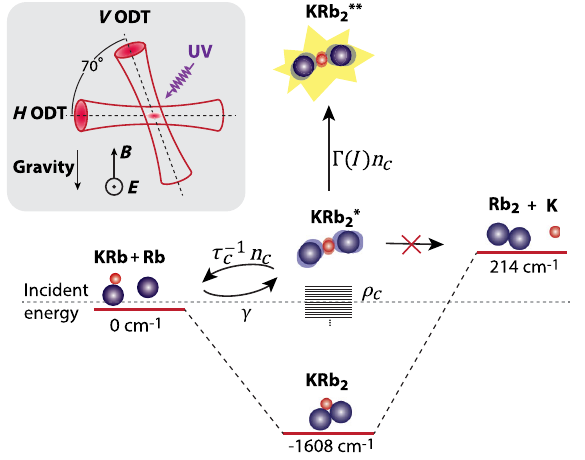
FIG. 1. Ultracold atom-molecule collisions in an optical dipole trap (ODT). Inset: a diagram of the ODT configuration used to confine the mixture of KRb molecules and Rb atoms. The H and V ODTs are formed from 1064 nm Gaussian beams with 1 =e 2 diameters of 70 and 200 μ m, respectively. The purple arrow represents the UV ionization laser pulse, which has a duration of 7 ns, used for photoionization of KRb 2 (cid:1) complexes. Electric ( E ) and magnetic ( B ) fields are applied to extract the ions and to maintain nuclear spin quantization, respectively. (b) Schematic illustration of the potential energy surface for collisions between KRb and Rb. The incident energy of one free electronic ground state Rb atom and one free KRb molecule in its rovibronic ground state is defined as the zero of energy. Because the Rb 2 þ K reaction channel is energetically forbidden at ultralow temper- atures, the collision must proceed through one of two pathways: KRb þ Rb ↔ KRb 2 (cid:1) or KRb þ Rb → KRb 2 (cid:1) → KRb 2 (cid:1)(cid:1) , where KRb 2 (cid:1)(cid:1) is an electronically excited state of the complex. The formation, dissociation, and photoexcitation rates of KRb 2 (cid:1) , as Þ n n defined in Eq. (1), are labeled as γ , τ − 1 , and Γ ð I , c c c tot respectively, and the density of states (DOS) of the complex near the incident energy is written as ρ . The ground-state c energies of KRb [39] and Rb 2 [43] are obtained from spectro- scopic data, whereas that of KRb 2 is calculated